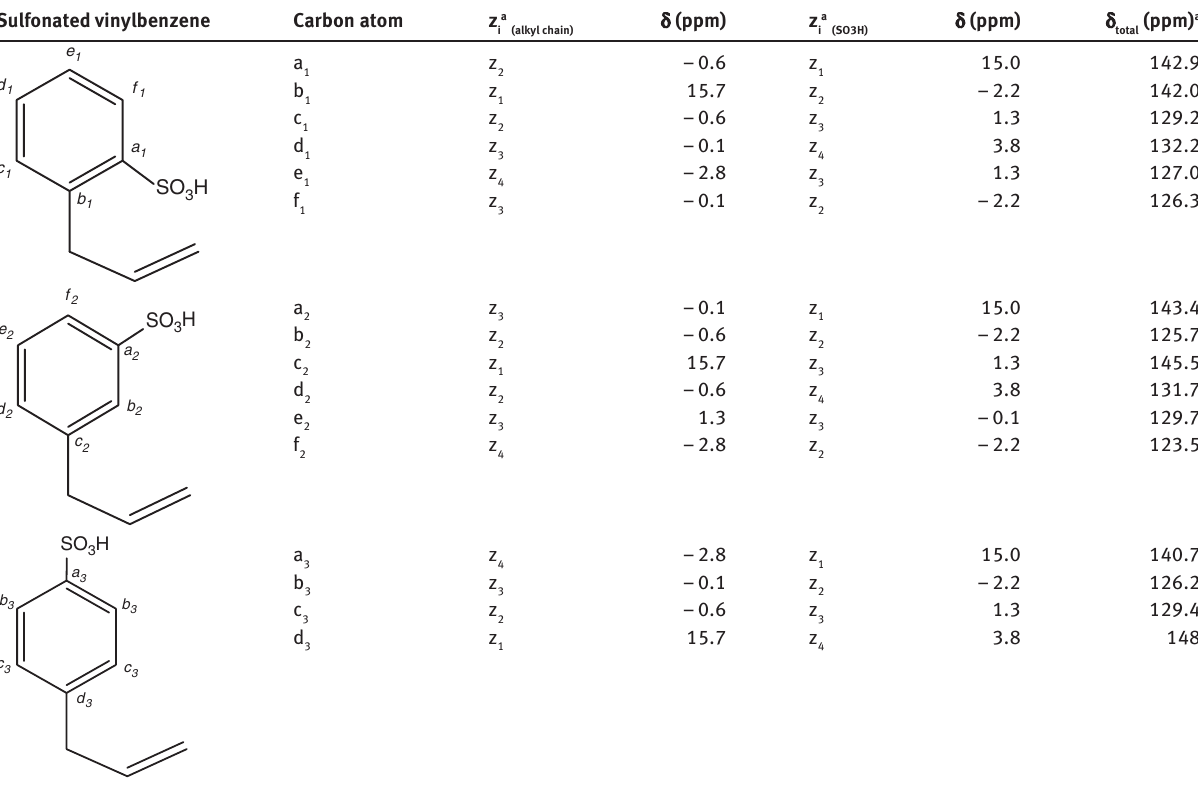
Table 2: Estimated 13 C-NMR shifts for the carbon atoms of vinylbenzene sulfonated at ortho- , meta- and para- positions [40, 41].